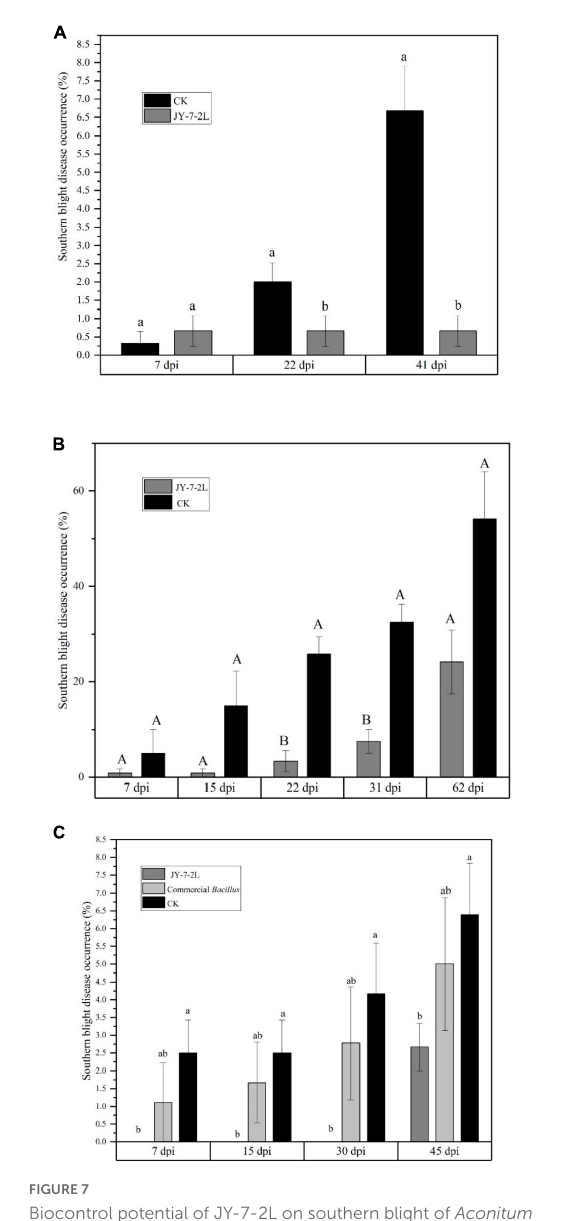
FIGURE7 Biocontrol potential of JY-7-2L on southern blight of Aconitum carmichaelii by field experiments. (A) Biocontrol efficacy of JY-7-2L on southern blight of A. carmichaelii in the field site of Southwest University of Science and Technology (SWUST) and (B) in Qiangchuan field in 2021; (C) biocontrol efficacy of JY-7-2L on southern blight of A. carmichaelii in SWUST field in 2022. Different lower-case or capital letters indicated significant difference ( p < 0.05 for lower-case letters and p < 0.01 for capital letters) according to one -way analysis of variance (ANOVA) with least significant difference (LSD)